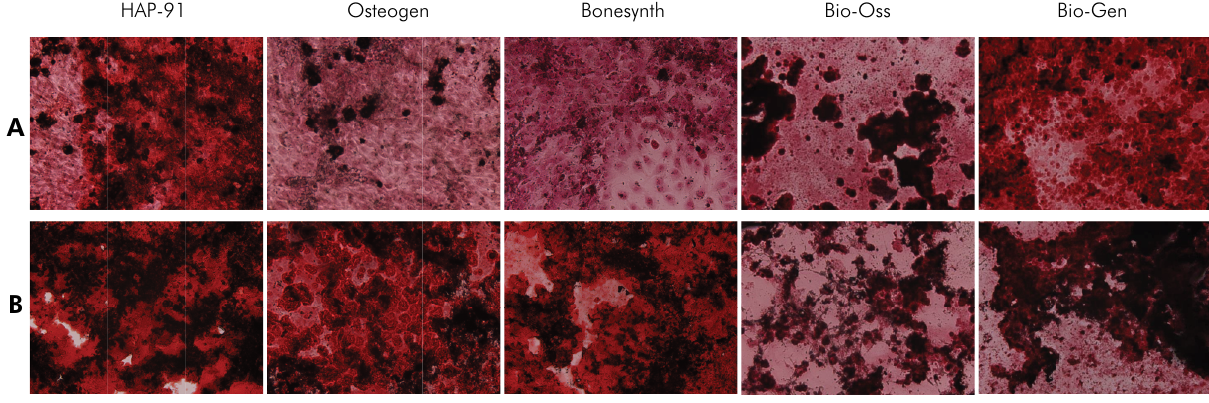
Figure 6. Representative bright-field images of alizarin red-stained MC3T3-E1 cells cultured in media conditioned with each HA under inductive conditions, considering the absence (a) or addition of 0.5% v/v budesonide (b).